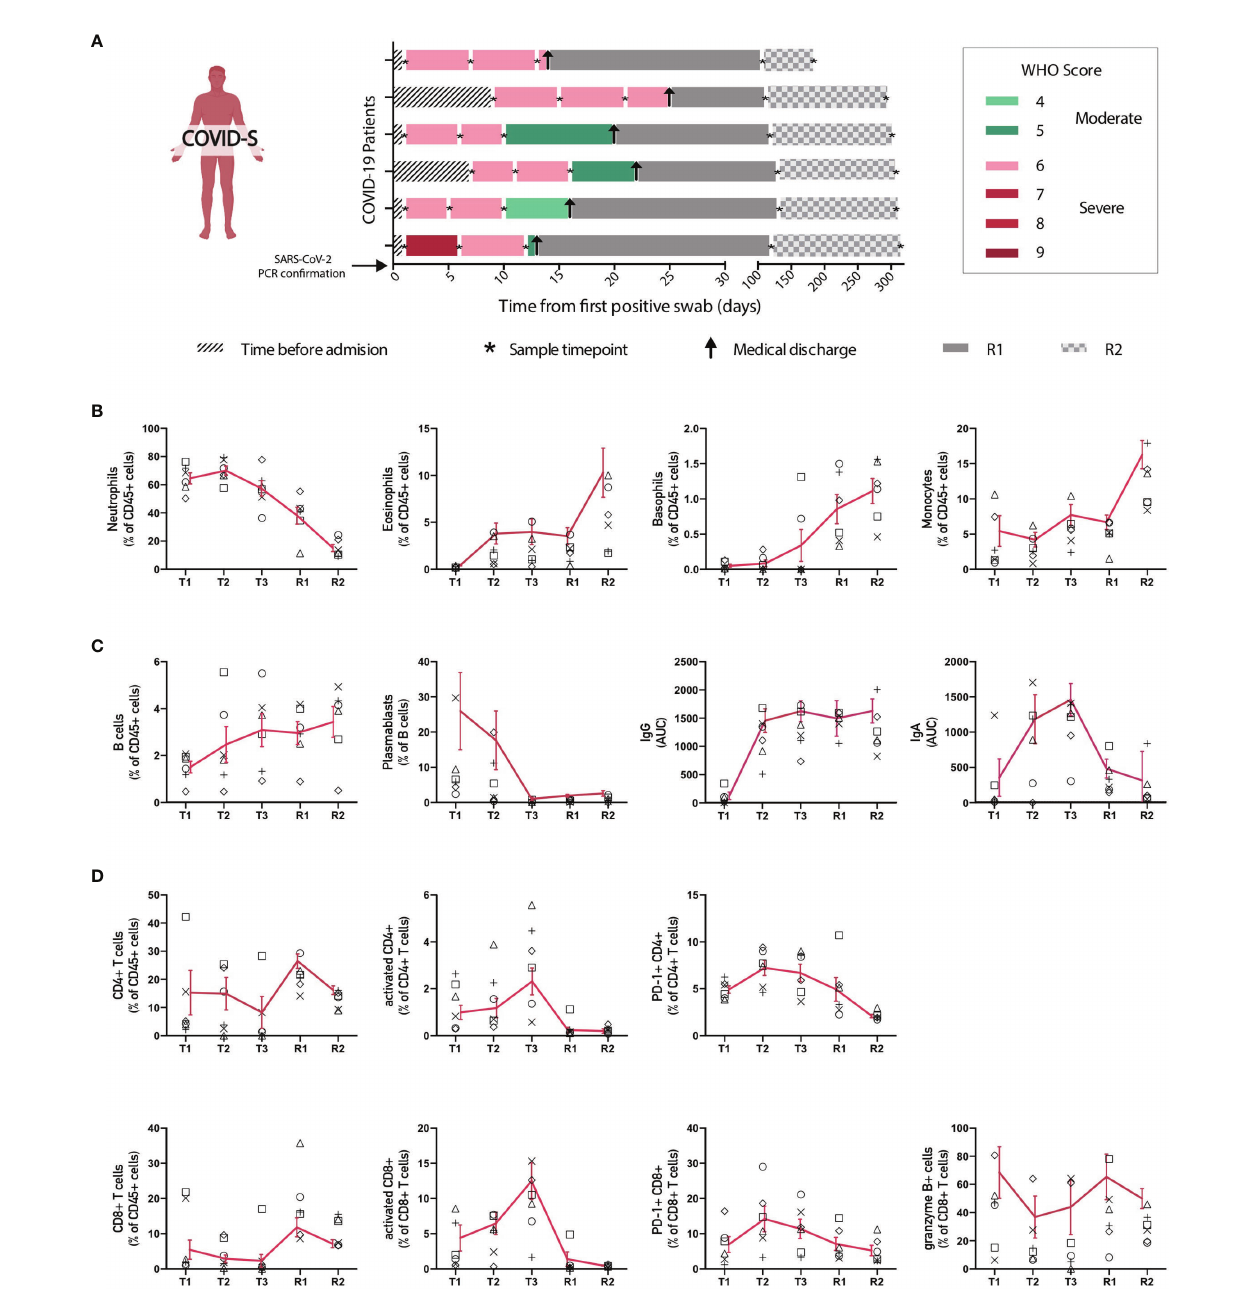
FIGURE 4 | Longitudinal analysis of immune populations in patients with severe SARS-CoV-2 infection. Main immune cell populations affected in severe COVID-19 patients were analyzed over time at different intervals until patient recovery. (A) Follow-up diagram of patients with severe COVID-19 disease. Peripheral blood samples from 6 patients with severe SARS-CoV-2 infection were collected at 3 different time points after ICU admission and SARS-CoV-2 PCR con fi rmation (T1, T2 and T3), plus two additional samples after recovery and clinical discharge (R1 and R2). The fi rst sample (T1) was taken upon ICU admission and positive SARS-CoV- 2 PCR, while second (T2) and third (T3) blood samples were taken 5-7 and 9-13 days after, correspondingly. R1 samples for follow-ups were taken once the patient had recovered and been released from the hospital, between 1 and 3 months after ICU admission. R2 samples were taken 6 months after patient recovery and clinical discharge. (B) Changes in frequency of innate immune populations during disease evolution and recovery. (C, D) Changes of adaptive immune components throughout time. Graphs show individual data for each patient and the mean ± SEM per group connected by a red solid